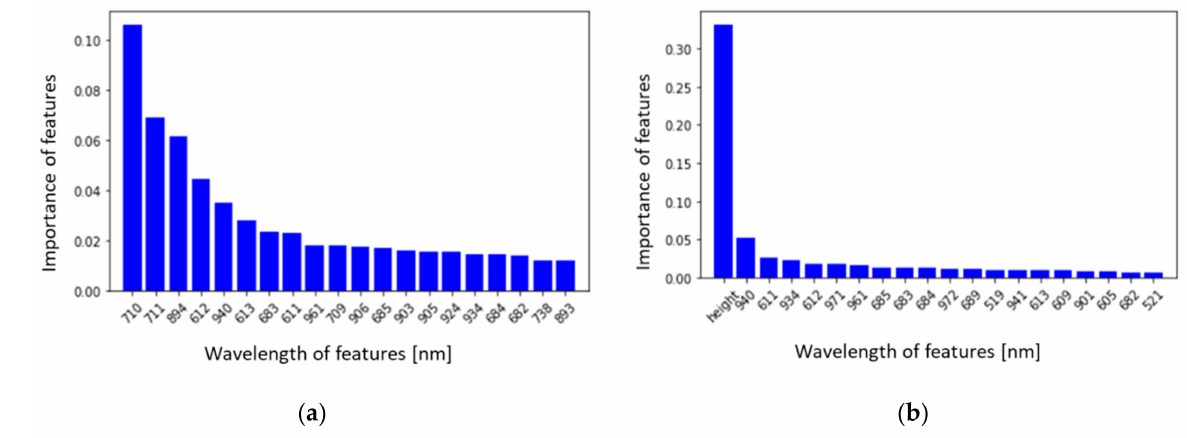
Figure 10. Importance of features of random forest regressor. ( a ) Trained to estimate NC from hyper spectrum; ( b ) Trained to estimate NC from the hyper spectrum with grass height. X-axis represents the wavelength of feature (Unit: nm) or grass height (indicated as height) while Y-axis represents the importance of features.